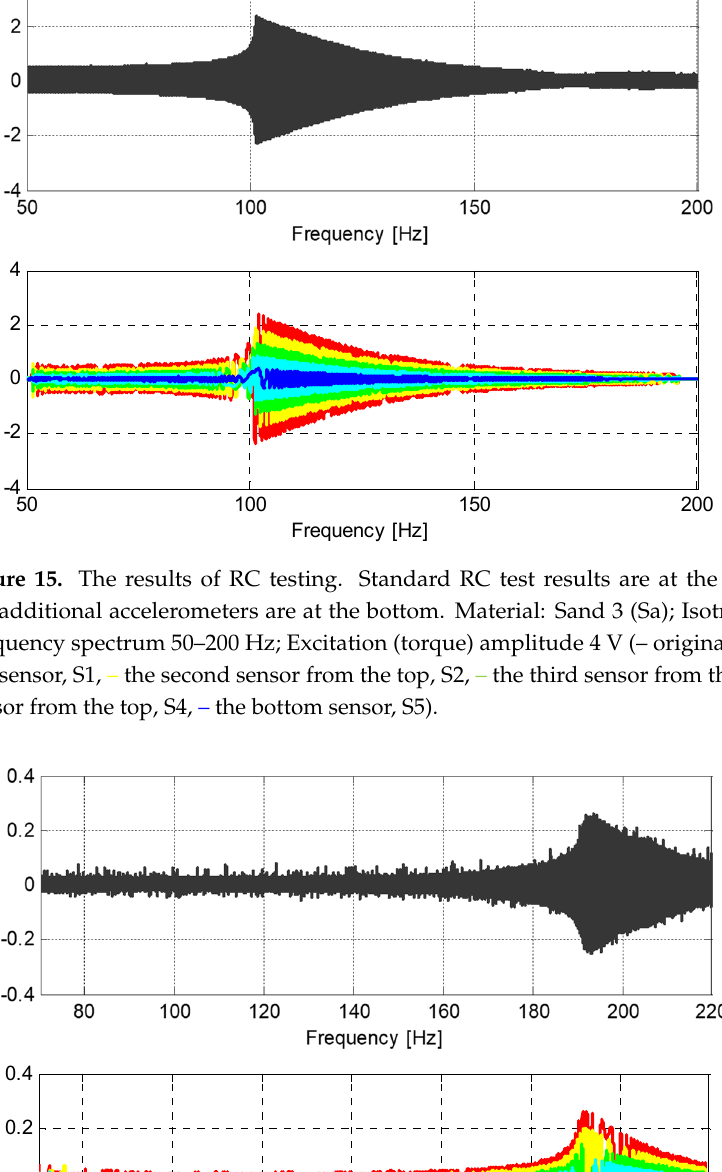
sensor from the top, S4, – the bottom sensor, S5).